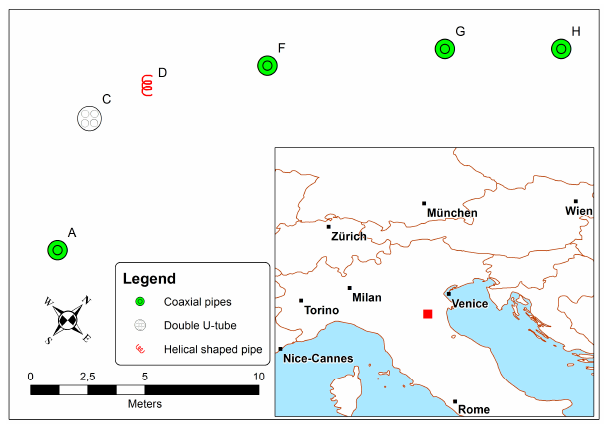
Figure 1. Testing site located in Molinella, slightly southwest of Venice. Table 1. List of the borehole heat exchangers assessed.